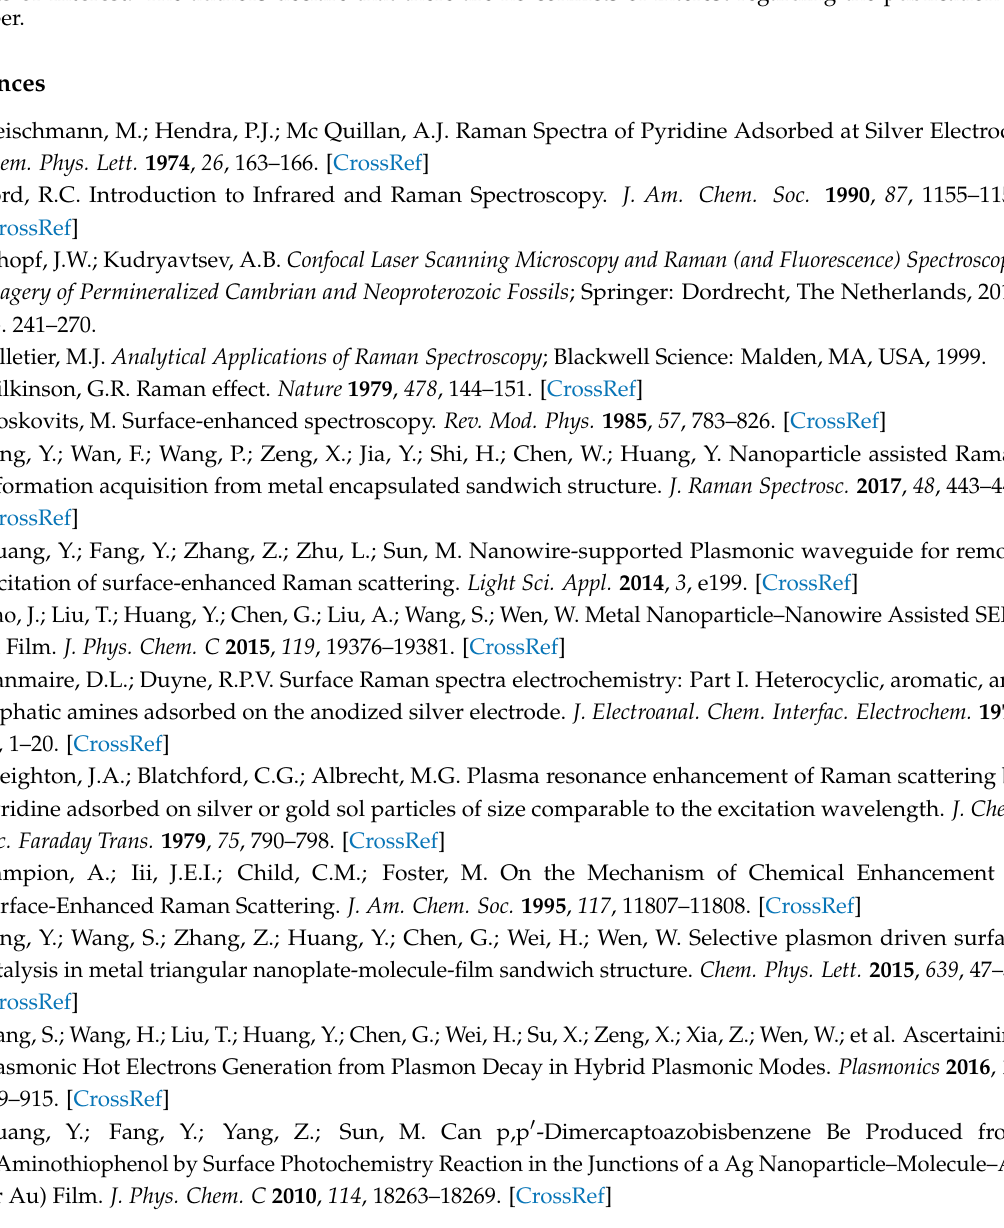
Figure S1: Raman spectra of pyridine–metal clusters simulated at the B3LYP/6-311+G** (C, N, H)/LanL2DZ(M) level. The unit of the differential Raman scattering cross is cm 2 molecule − 1 sr − 1 . (Figure comes from reference [2]), Figure S2: Experimental Raman spectra: The black line represent Raman spectra of pure furfural. The red line and blue line represent the Raman signals of furfural on gold or silver particles,